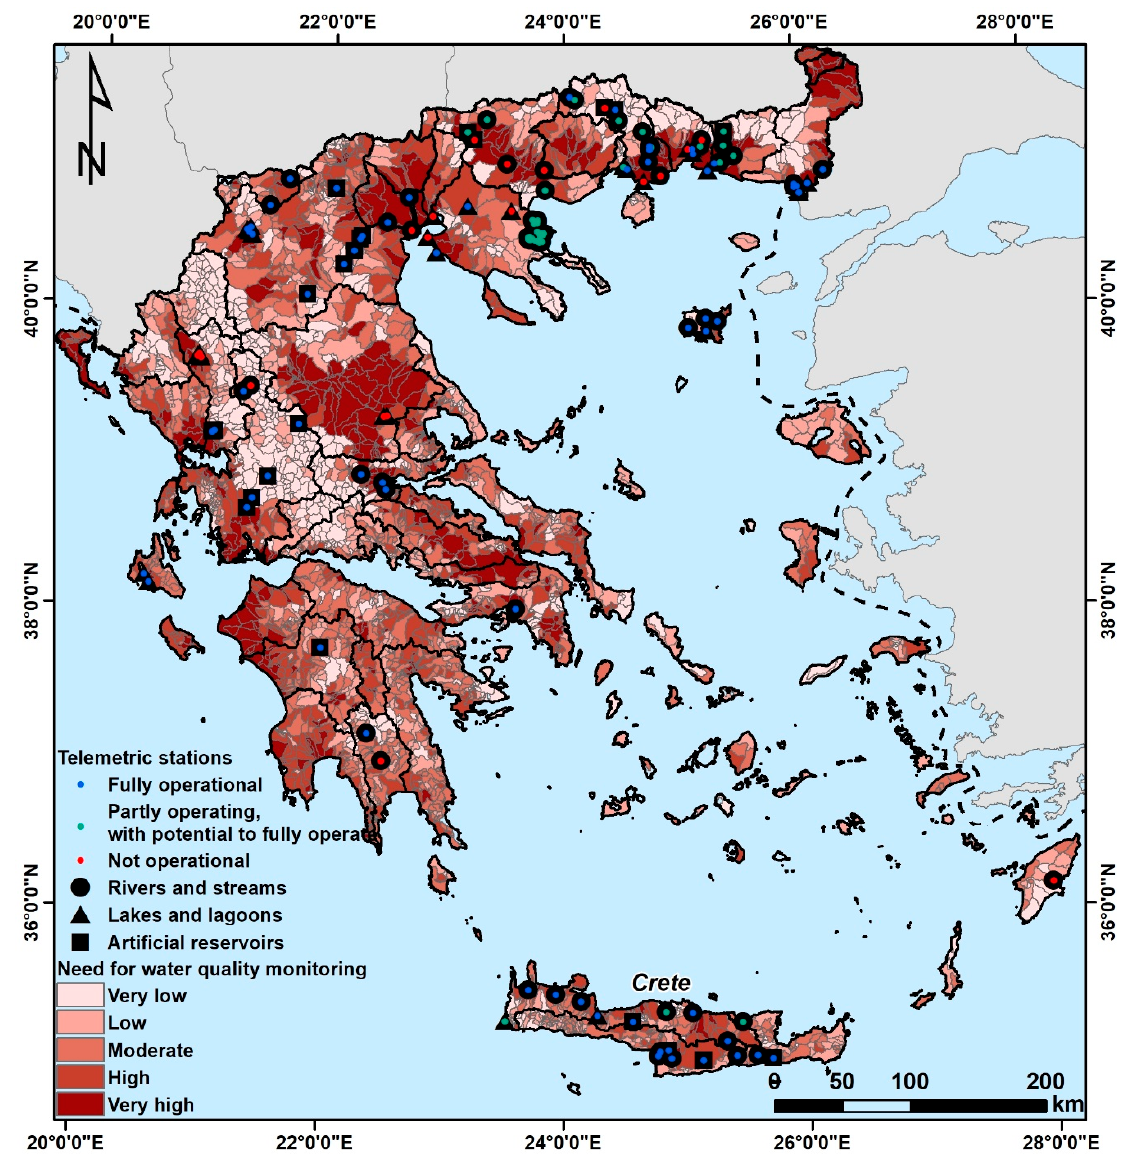
Figure 6. Water quality monitoring stations of surface waters which operate or operated in Greece along with the monitoring needs across the country expressed with colored differentiation.